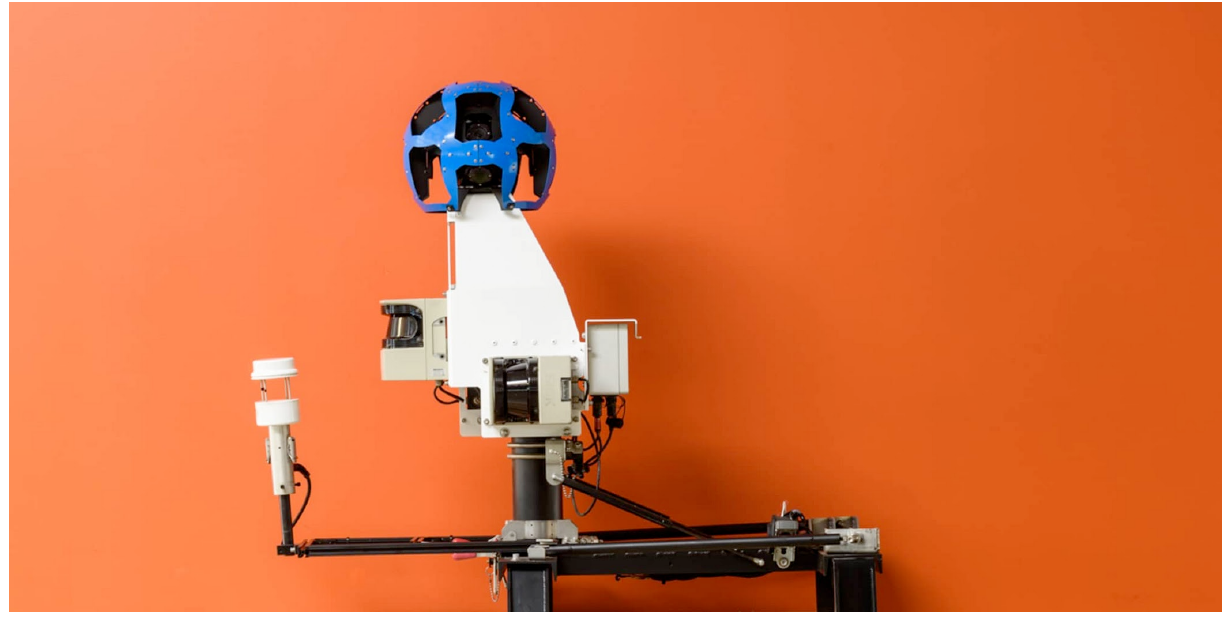
Figure 3: Google Street View air-pollution sensors. Image courtesy of Google. Available at